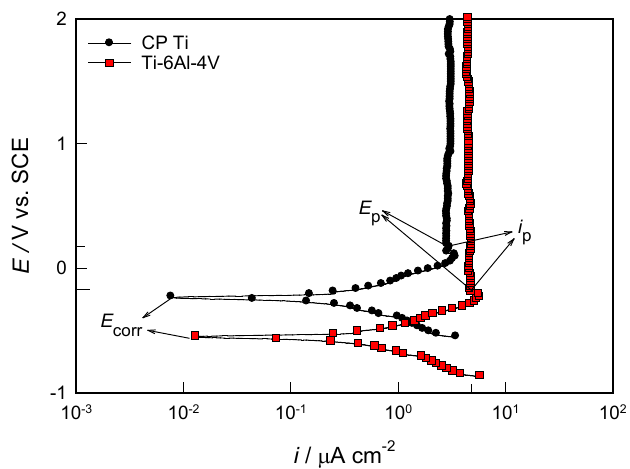
Figure 3. Potentiodynamic polarization curves of the investigated samples in PBS solution. As seen from Figure 3, both samples exhibited similar passivation behaviour and even up to 2.0 V the oxide films formed on both samples did not breakdown. Similar behaviour was observed for Ti and Ti-6Al-4V alloy in different corrosive environments of the human body [20,31,33]. For the investigated samples, characteristic values of corrosion potential ( E corr ), corrosion current density ( i corr ), passivation potential ( E p ), and passivation current density ( i p ) were determined from the polarization curves and shown in Table 2, along with the data for the polarization resistance ( R p ). According to the polarization data, the smaller i corr and i p and the more positive E corr and E p showed CP Ti. The CP Ti sample also has a higher value of R p (corrosion resistance) due to the better protective properties of the oxide film. Table 2. Corrosion parameters for the CP Ti and Ti-6Al-4V alloy in PBS solution. Sample